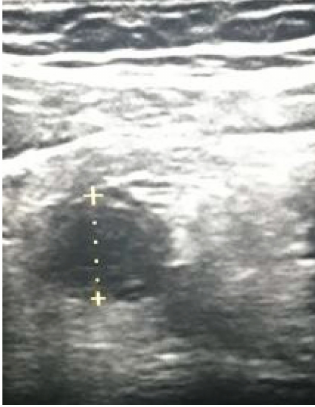
Figure 5. Acute appendicitis (diameter of appendix 11.9